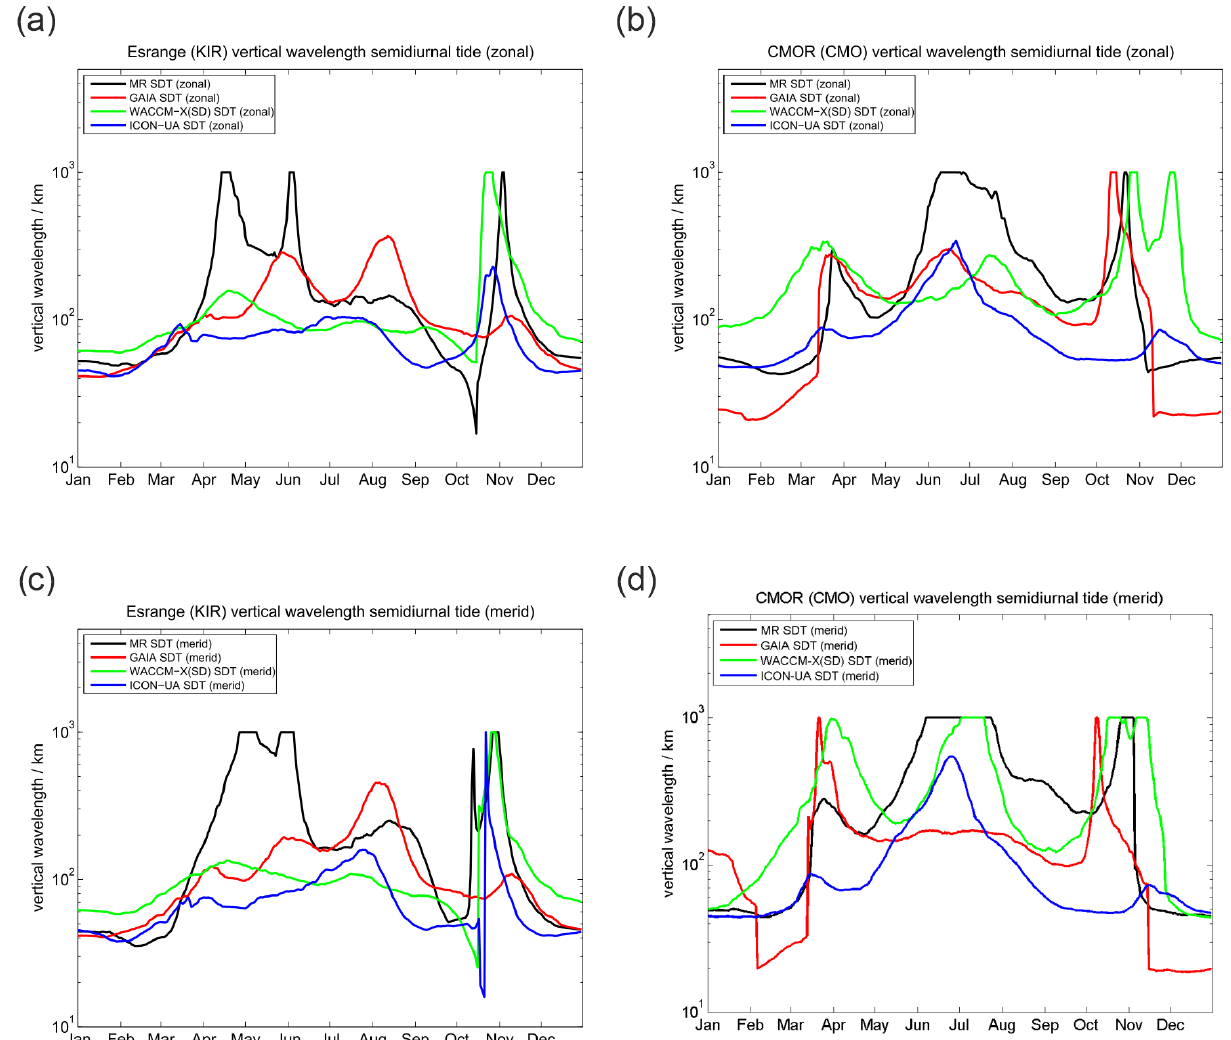
Figure A7. The same as Fig. 8, but for KIR and